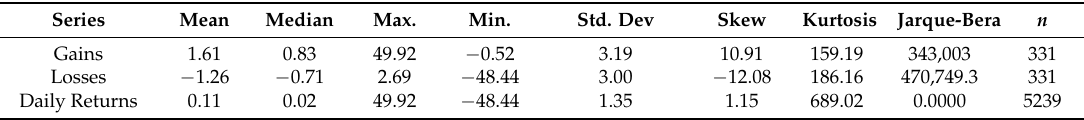
Table 1. Maximum monthly gains, falls and returns (descriptive